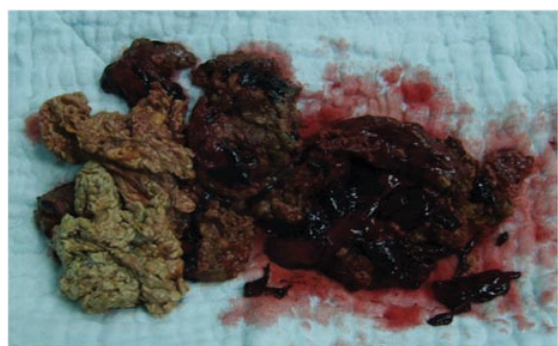
Figure 1. The pancreas in cross section after the necrosectomy revealing caseating